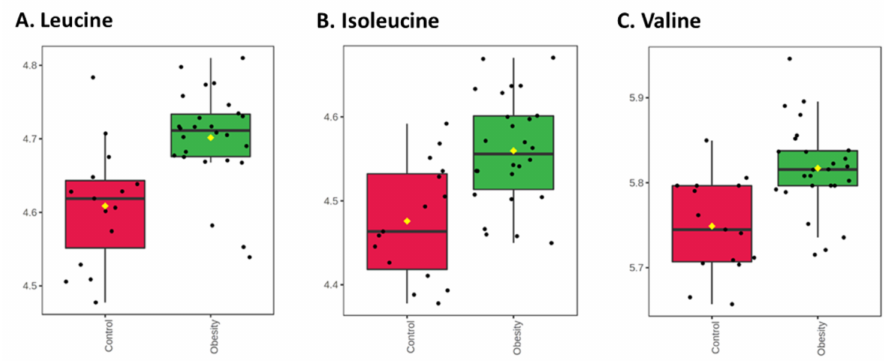
Figure 4. Box-plots of BCAAs with significantly different concentrations between children with (green) and without (red) obesity. Fold changes and p -values are provided in Table S1. ( A ) Leucine; ( B ) Isoleucine; ( C )